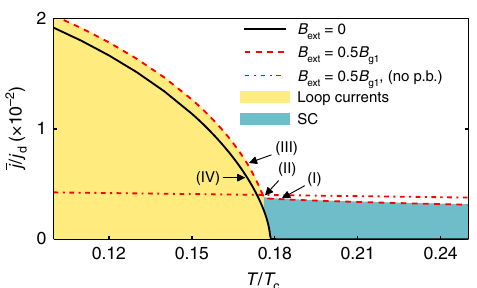
Fig. 4 Current as a function of temperature. The area-averaged current magnitude, de fi ned in Eq. (4), is plotted for zero external magnetic fi eld (solid line), with an external magnetic fi eld of magnitude B ext = 0.5 B g1 (dashed line), and for a system without pair-breaking edges at B ext = 0.5 B g1 (dash-dotted line). In the latter case, the system only displays a diamagnetic response. Letters (I) – (IV) indicate the parameter values corresponding to the fi elds in Fig. 2, see Table 1